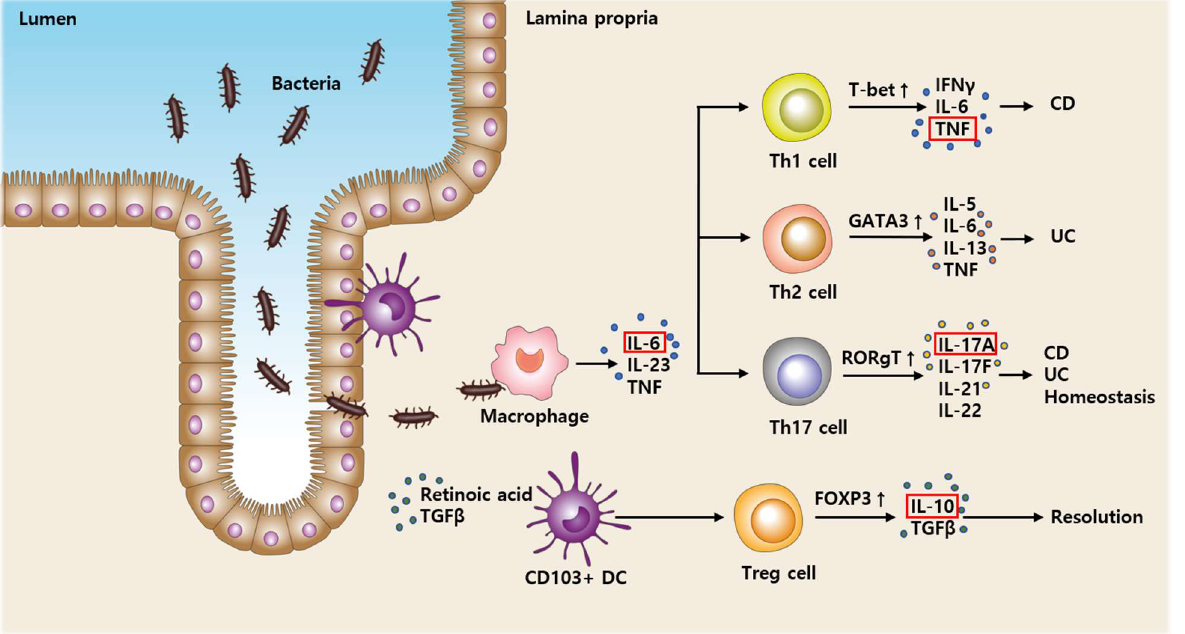
Figure 1. Depicting the process of T cells activation using cytokines from each T cell subset. IL: Interleukin, DC: Dendritic cell, TGF: Transforming growth factor, Th: T helper, Treg: T regulatory, T-bet: T-box expressed in T cells, GATA3: transcription factor that, in humans, is encoded by the GATA3 gene, RORγt: RAR-related orphan receptor gamma, FOXP3: Forkhead box P3, TNF: Tumor necrosis factor, IFN: Interferon, CD: Crohn’s disease, and UC: Ulcerative colitis.